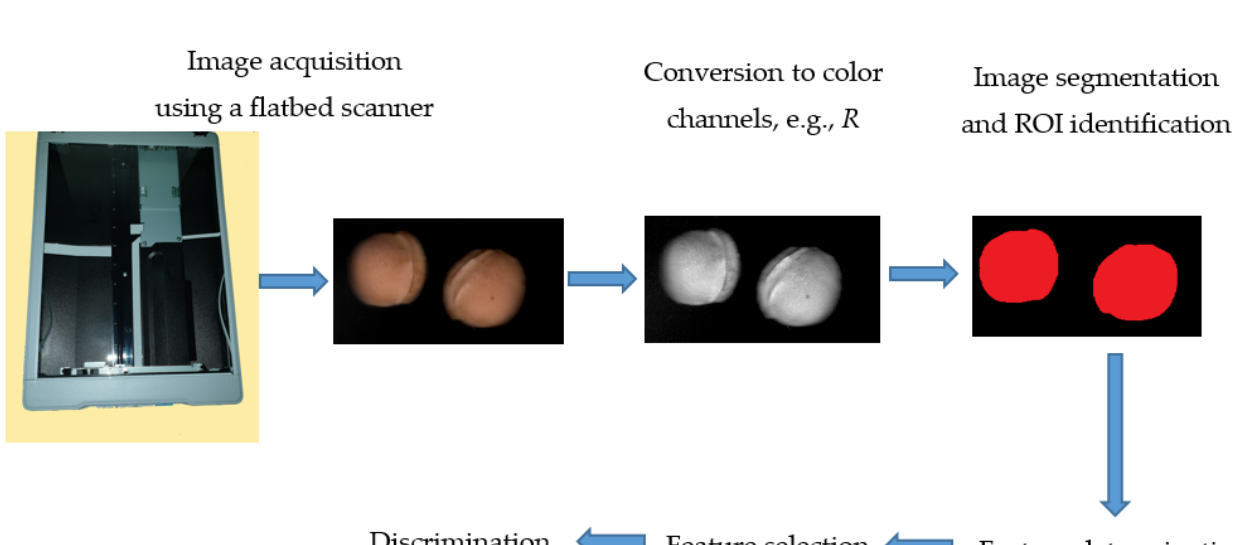
Figure 1. The image analysis steps for cultivar discrimination of sweet cherry endocarp. The regions of interest (ROIs) were identified using the segmentation of the images. Each ROI including a pit was a set of pixels separated from the black background using the manually determined brightness threshold. The used version of MaZda application allowed to convert the images to individual color channels. Exemplary images of sweet cherry pits ‘Kordia’, ‘Lapins’ and ‘Büttner’s Red’ from selected color channels are presented in Figure 2. Based on the converted images, the suitability of individual color channels for further discriminant analysis was visually examined. In the case of R , G , B , L , a , b , X , Y , and Z color channels, the differences between the pits of individual cultivars allowing for their distinction, were observed. Therefore, images from these color channels were chosen for the texture calculation. Color channels R , G , B were from RGB color space, color channels L , a , b -from Lab color space and X , Y and Z -from XYZ color space. The RGB color space refers to red ( R ), blue ( B ) and green ( G ). The Lab color space depends on the position in a 3D color space. The L* is the lightness component from black to white, a* indicates green for negative values and red for positive values and b* indicates blue for negative values and yellow for positive values. In the case of XYZ color space, Y indicates lightness and X and Z components are color information [16].